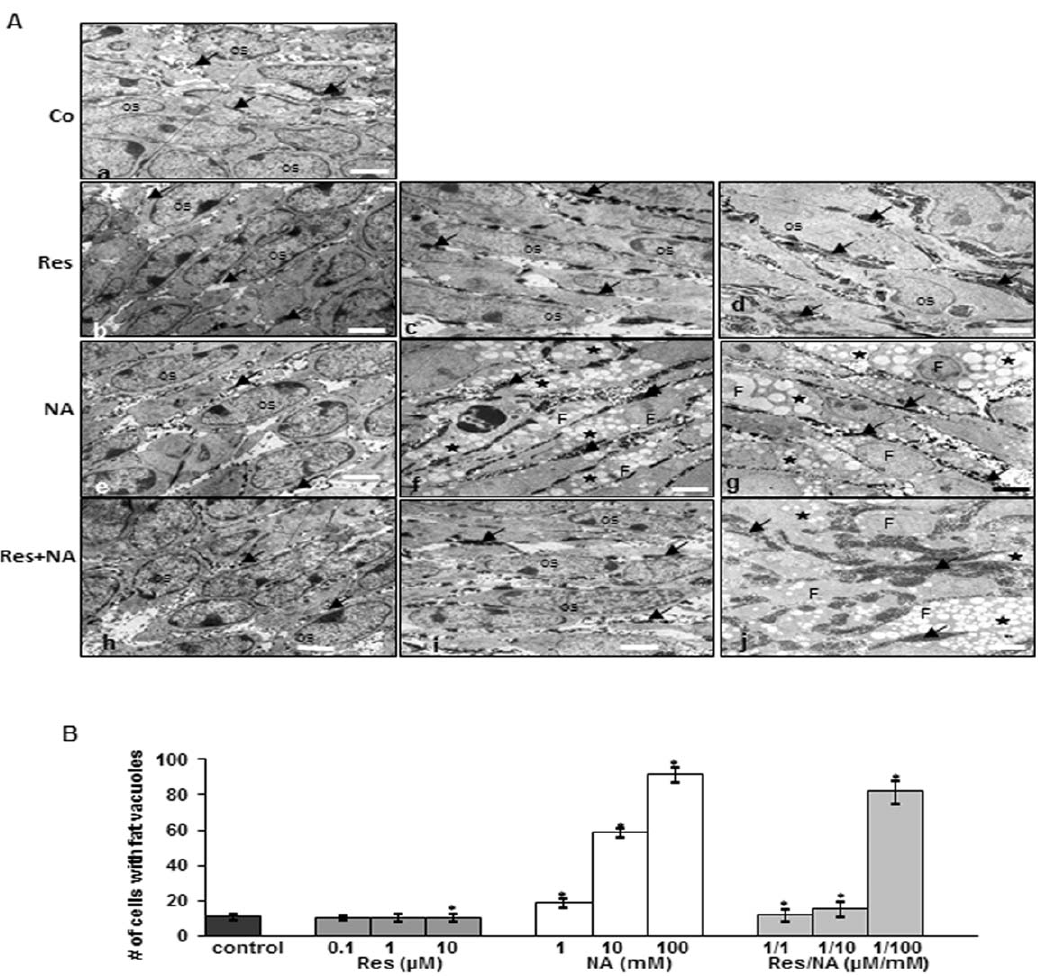
Figure 2. Transmission electron microscopic (TEM) studies of the effects of resveratrol on osteoblastic differentiation of MSCs in high-density culture. A: a–d: 14 days in high-density culture. Cultures were stimulated with osteogenic induction medium (a) and with various concentrations of resveratrol (0.1 m M (b), 1 m M (c), 10 m M (d)). TEM revealed details of ultrastructural changes that the MSCs underwent while differentiating into osteoblasts (Os). Cells contained high levels of nuclear euchromatin and a large number of sub-cellular organelles (mitochondria, rough ER, Golgi apparatus). Large quantities of thick extracellular matrix fibrils (arrows) were observed in the extracellular space (arrows). However, no significant differences in osteogenesis were observed at the ultrastructural level between resveratrol-treated and control MSC cultures. Magnification: 5000 6 , bar=1 m m. A: e–g: 14 days in high-density culture. MSC cultures were treated with osteogenic medium and with the sirtuin inhibitor nicotinamide (1 mM (e), 10 mM (f) and 100 mM (g)). TEM clearly demonstrated that MSCs differentiated into adipocytes (F), exhibiting cytoplasmic lipid droplet accumulation (*) in the presence of osteogenic induction medium. The adipocytes produced high quantities of ECM (arrows) and were embedded in this well organized matrix. Magnification: 5000 6 , bar=1 m m. A: h–j: 14 days high-density culture. MSCs were pre-treated with 1 m M resveratrol for 4 h and then co-treated with various concentrations of nicotinamide (1 mM (h), 10 mM (i) and 100 mM (j)) in osteogenic medium. Pre- treatment of MSCs with 1 m M resveratrol and co-treatment with 1 and 10 mM nicotinamide inhibited adipogenic differentiation of MSCs, favoring osteoblastic differentiation. However, co-treatment with 100 mM nicotinamide resulted in adipogenesis. Magnification: 5000 6 , bar=1 m m. B: Adipocyte differentiation in the cultures was estimated by counting 100 cells from 20 different microscopic fields. The number of adipocytes was highest in cultures stimulated with 100 mM nicotinamide alone. However, cells pre-treated with resveratrol and co-treated with nicotinamide at 1 or 10 mM but not at 100 mM nicotinamide significantly decreased the number of adipocytes compared to the chemical by itself